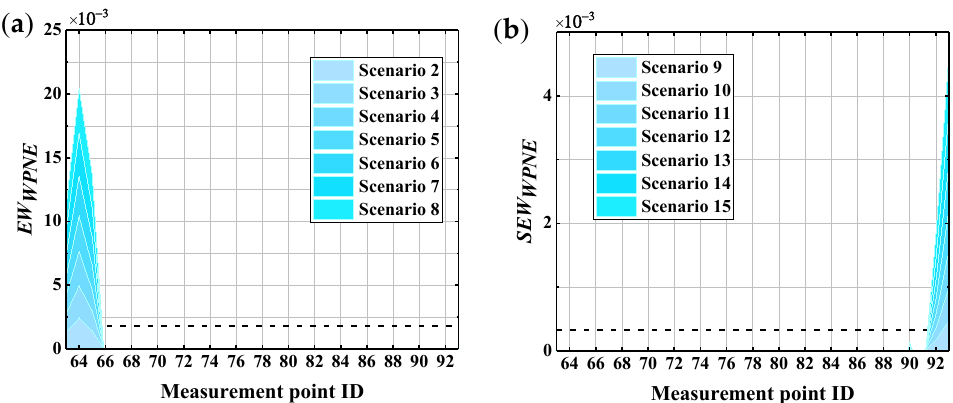
Figure 22. Accelerogram of WN earthquake.